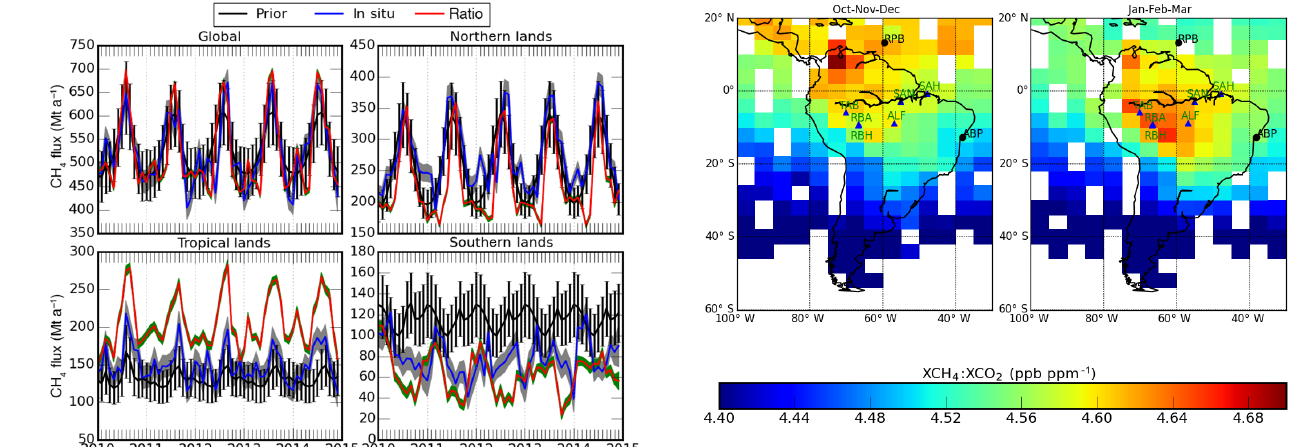
Figure 5. GOSAT XCH 4 :XCO 2 ratios over tropical South Amer- ica (Fig. 1) described on the GEOS-Chem 4 ◦ (latitude) by 5 ◦ (lon- gitude) averaged over (left) October to December 2013, inclusive, and (right) January to March 2014, inclusive. Black dots repre- sent two NOAA in situ sites RPB (Ragged Point, Barbados) and ABP (Arembepe, Bahia, Brazil), and triangles represent indepen- dent AMAZONICA sites (RBA, ALF, TAB, SAN) and two ACO sites (RBH, SAH), which are described in the main